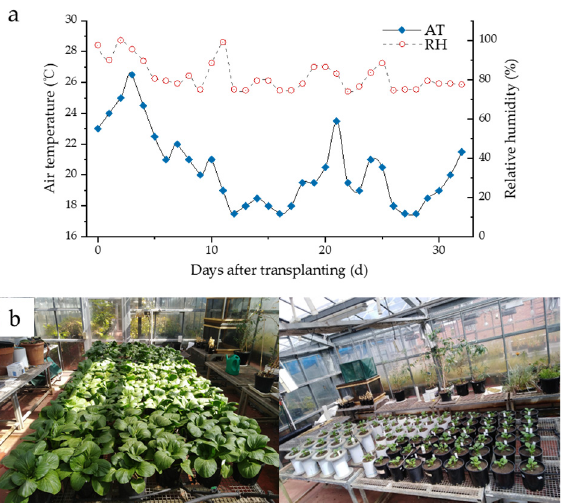
Figure 1. Experimental layout: a. Dynamics of air temperature (AT) and relative humidity (RH) in the greenhouse shed; b. Pot arrangement at the greenhouse shed, on harvest ( left ) and after transplanting during 3–4 leaf age ( right ). Table 1. Physical and chemical properties of brown coal (BC), organic manure and sandy loam soil. Material Sandy